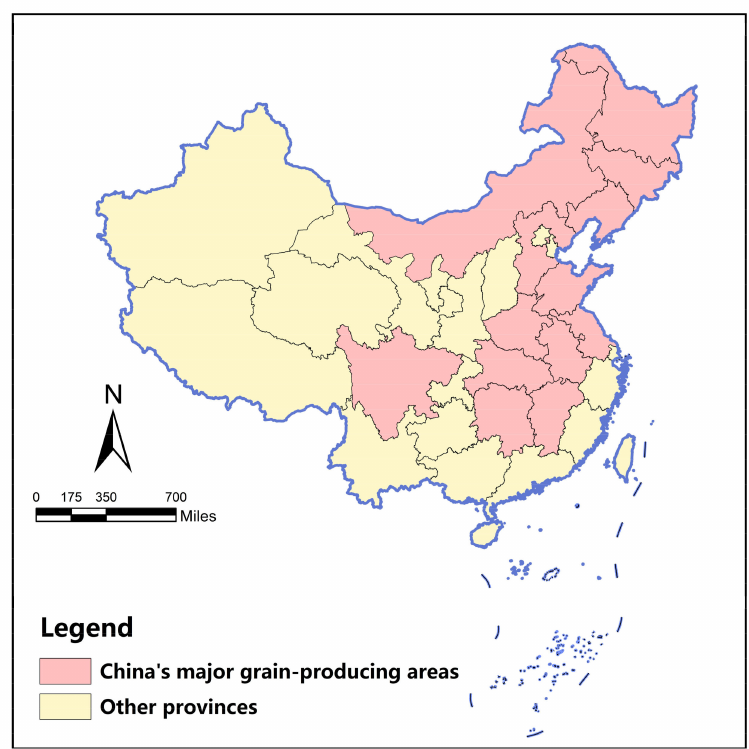
Figure 1. The location of 13 provinces of China’s major grain-producing areas (the map of China in the figure was produced under the supervision of the Ministry of Natural Resources of People’s Republic of China, drawing number: GS (2019) No.